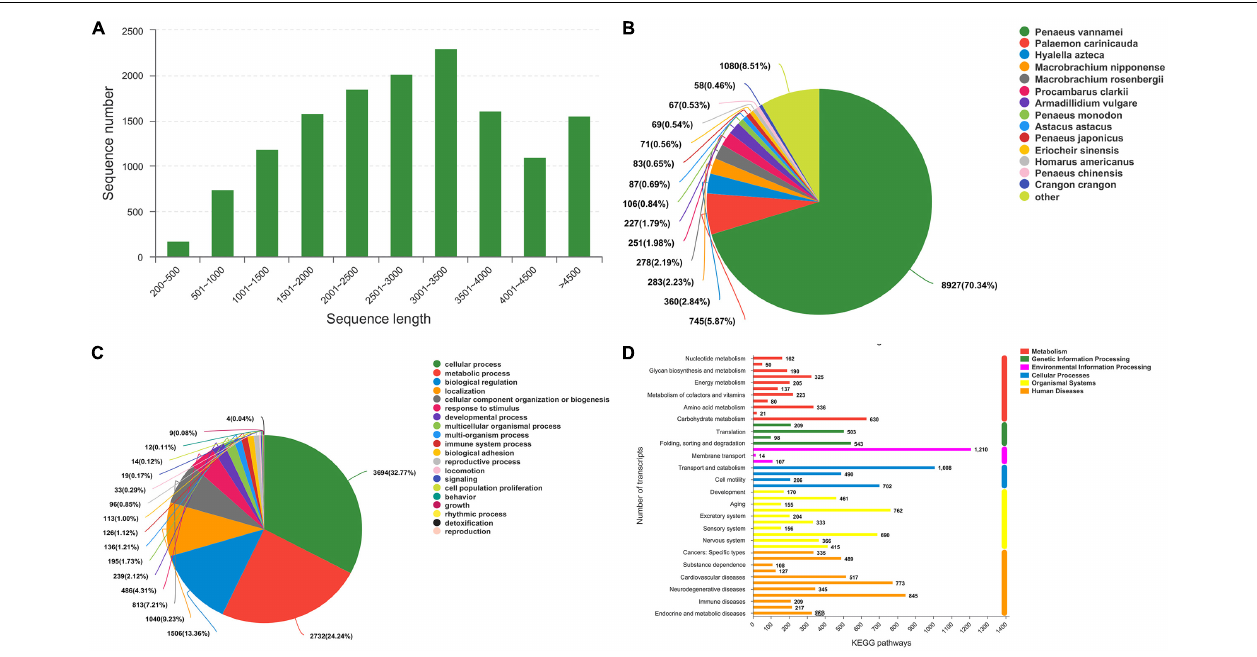
FIGURE 3 | Transcriptome sequence length distribution and annotation. (A) Sequence length distribution. (B) Species Distribution. (C) GO Classification_BP. (D) Histogram of KEGG.